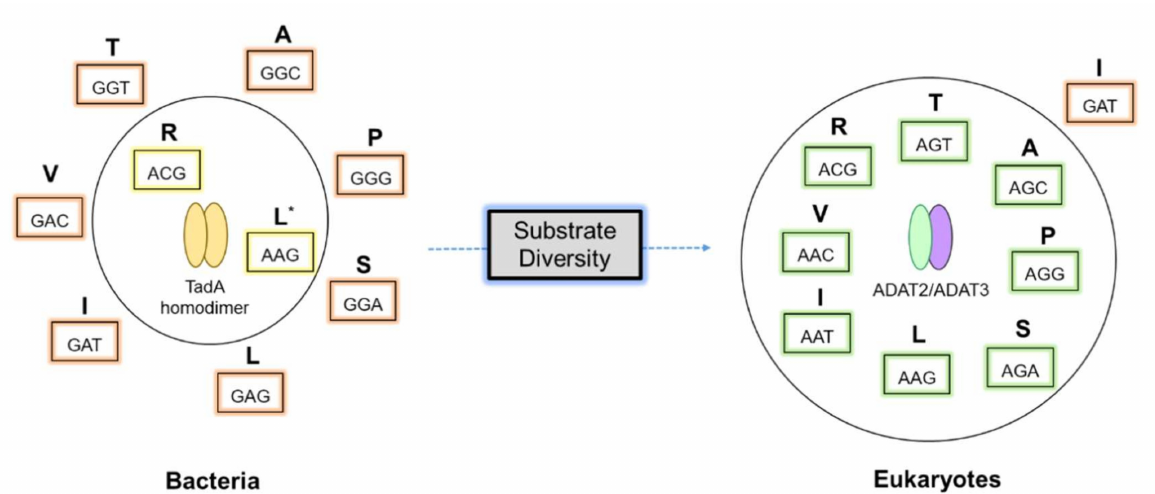
Figure 4. Substrate diversity of tRNA-specific deaminases. In bacteria, tRNA Arg ACG is a well-established A 34 substrate for homodimeric TadA. * Inosine modified tRNA Leu AAG is also found in a few prokaryotes such as O. oeni [65]. In eukaryotes, diverse A 34 tRNAs serve as substrates for heterodimeric ADAT2/3 where the population of G 34 tRNAs is limited. The expansion of A 34 tRNA diversity co-evolved with multisubstrate specificity in ADATs. (The anticodons are boxed, and the corresponding amino acids are